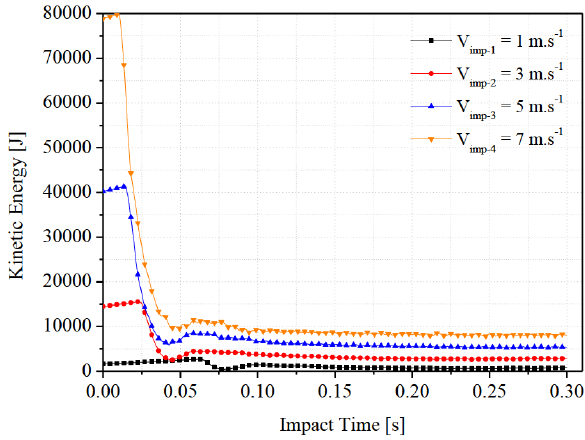
Figure 7: Kinetic energy of the system. Due to the moving object was only the container, this energy represents movement tendency of the